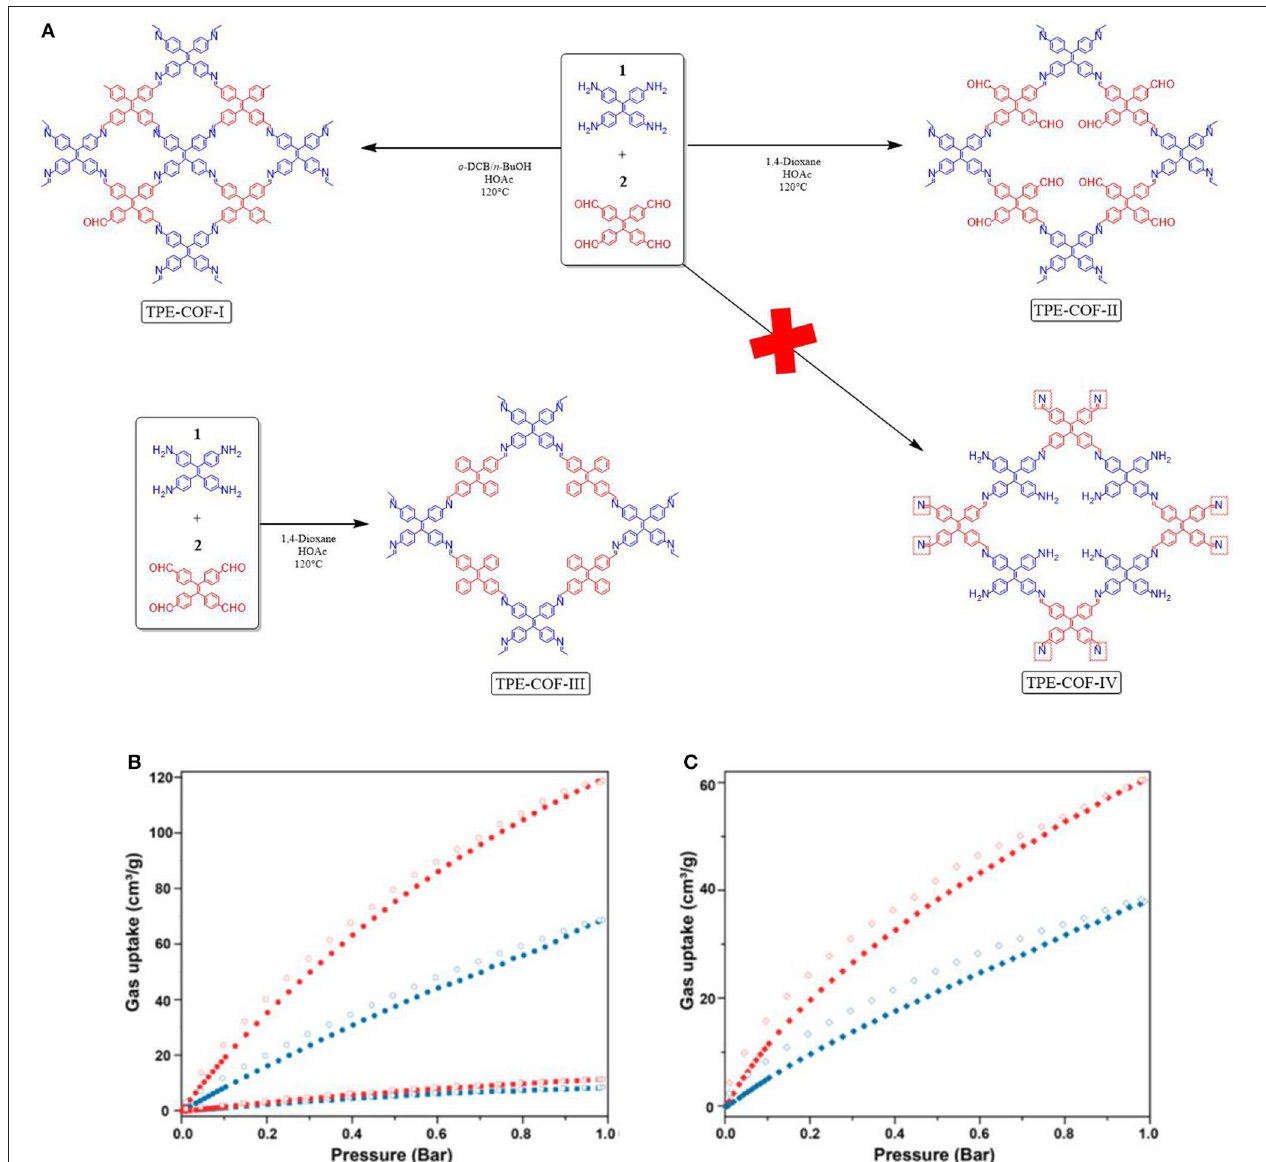
FIGURE 6 | Preparation of TPE-COFs by different reaction conditions yielding different COF structures. (A) Gas sorption isotherms of TPE-COFs. (B) CO 2 adsorption isotherm of TPE-COF-II at 273K (red •) and TPE-COF-I (blue •) at 273K; N2 adsorption isotherm of TPE-COF-II at 273K (red (cid:4) ) and TPECOF-I (blue (cid:4) ). (C) CO2 adsorption isotherm at 298K of TPE-COFII (red (cid:7) ) and TPE-COF-I (blue (cid:7) ) as determined by Loh et al. Reprinted with Permission © 2018 The American Chemical